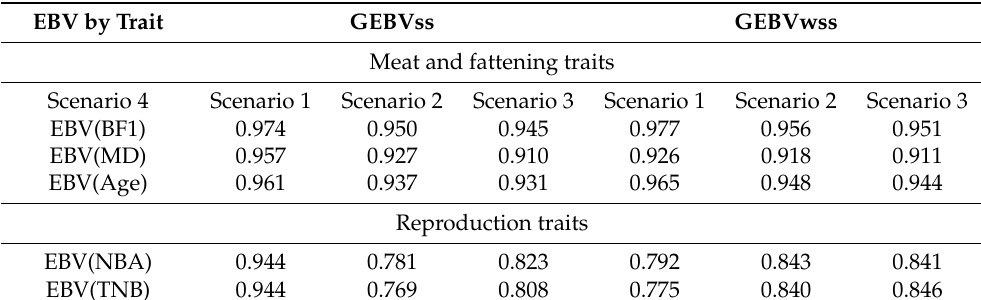
Table 6. Correlation of EBV/GEBV of individuals of the first and fourth reference groups (530 and 396 heads) obtained by compared methods